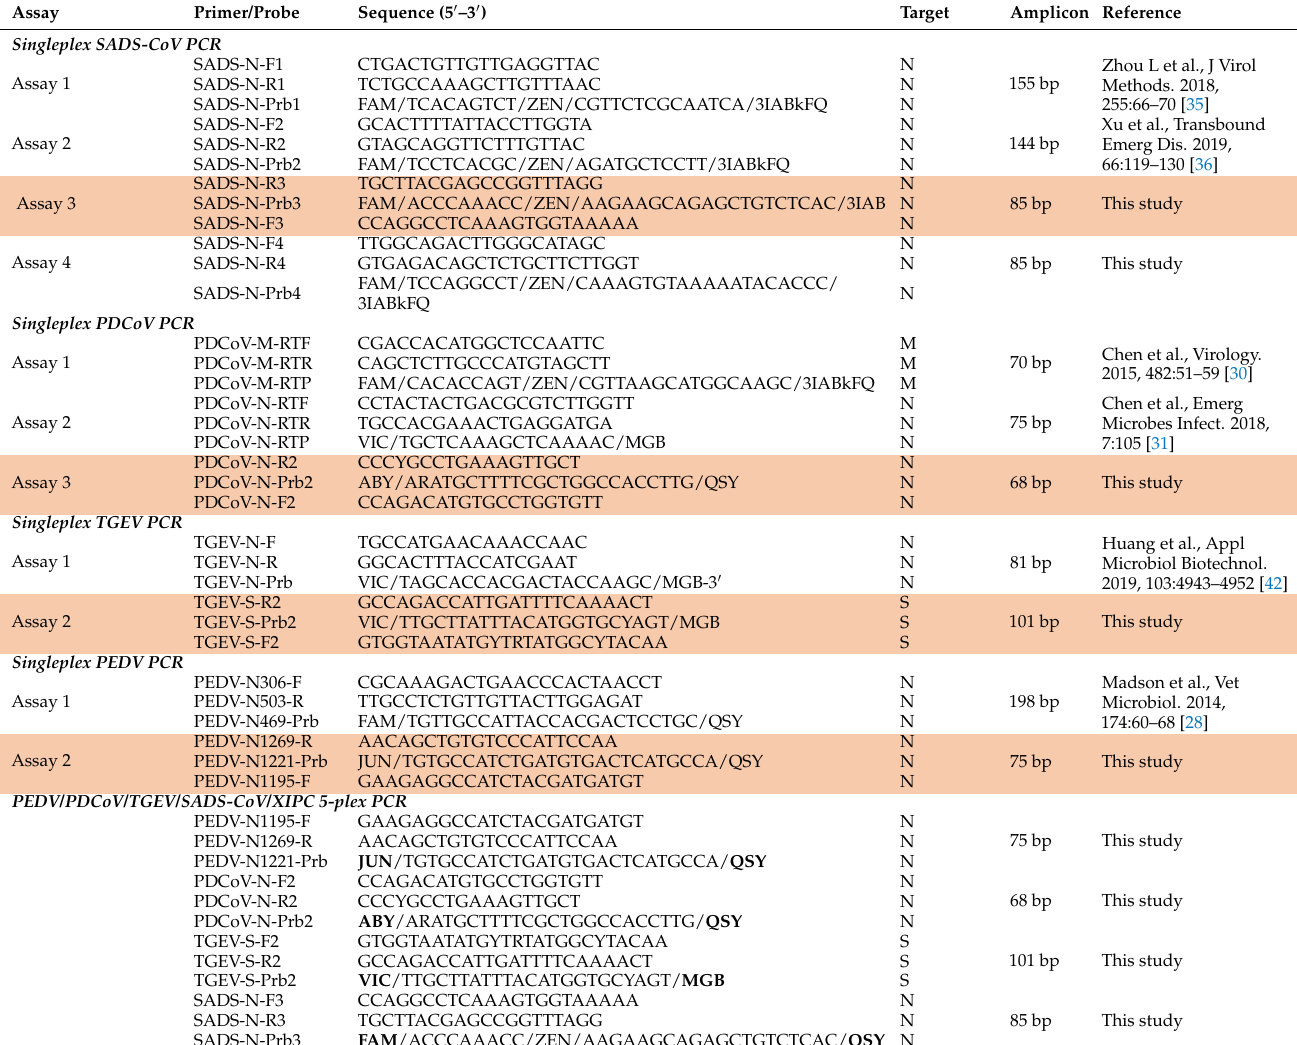
Table 1. Sequences of primers and probes used in this